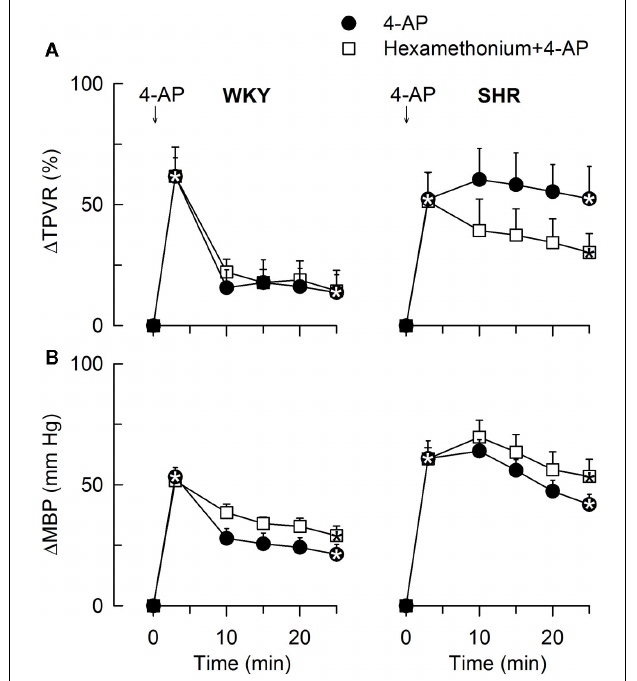
FIGURE 11 |TheTPVR- (A) and MBP- (B) response to 4-AP after atropine and vagal nerve stimulation. Significant responses (* within symbols) at the initial peak response and after 25min were detected as indicated. Significant group differences were not detected. Atropine and vagal nerve stimulation did not alter MBP andTPVR baselines ( Table 2 ). * – P ≤